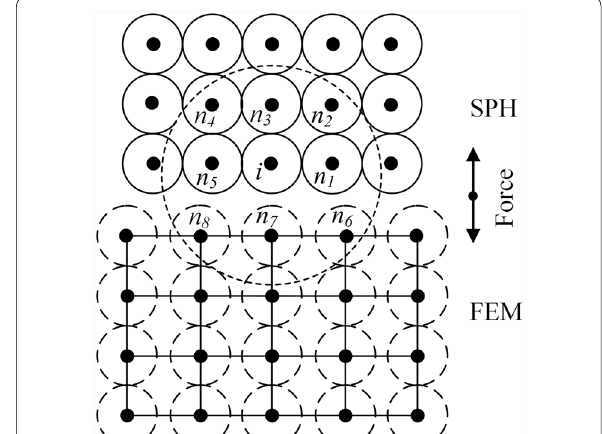
Figure 3 SPH-FEM element contact